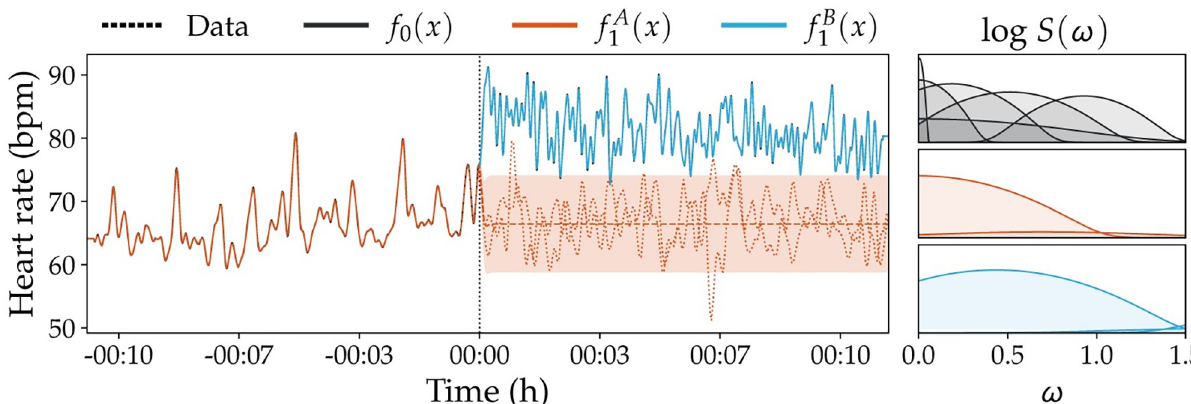
Fig 6. Kundalini meditation effect on heart rate. Analysis of meditation effect on heart rate. Shown is the participant’s heart rate, who starts meditation at x 0 = 00: 00. The extrapolation, indicated by the dashed (mean) and dotted (posterior samples) red lines, is poor in comparison to the actual observations, which is corroborated by the large log Bayes factor. The panel on the right shows the (log) power spectra expressed by the optimized covariance function